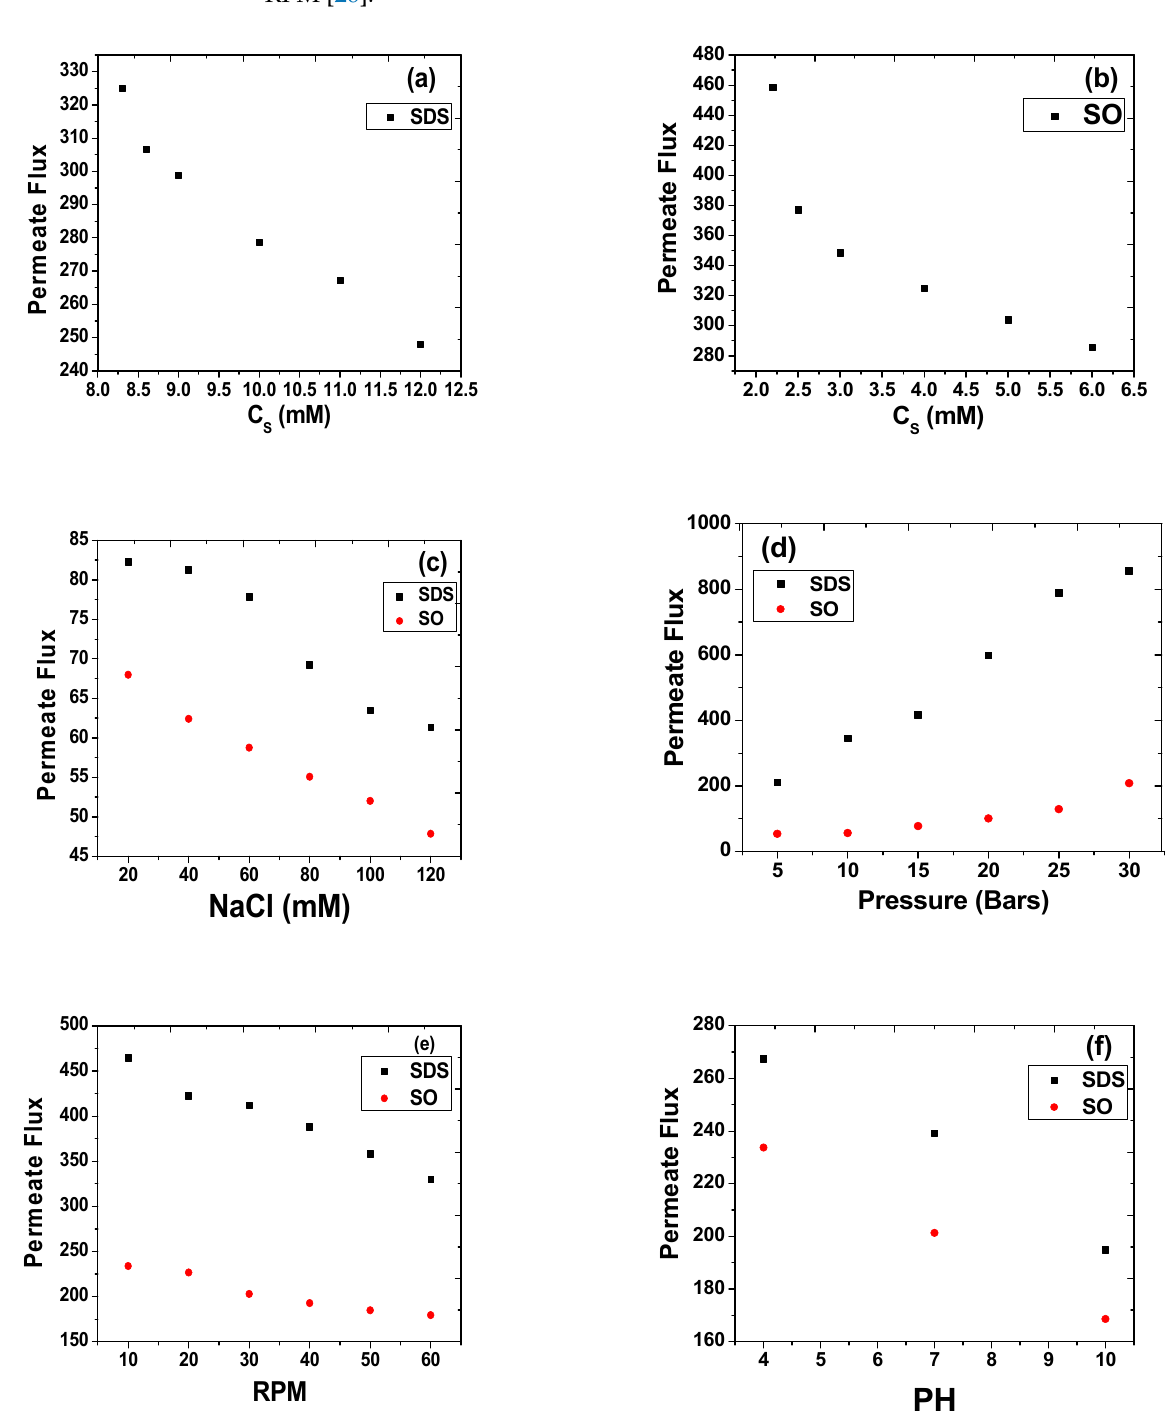
Figure 5e as well as in Table 5. Hence, a decline in the permeate flux was observed with RPM [26].